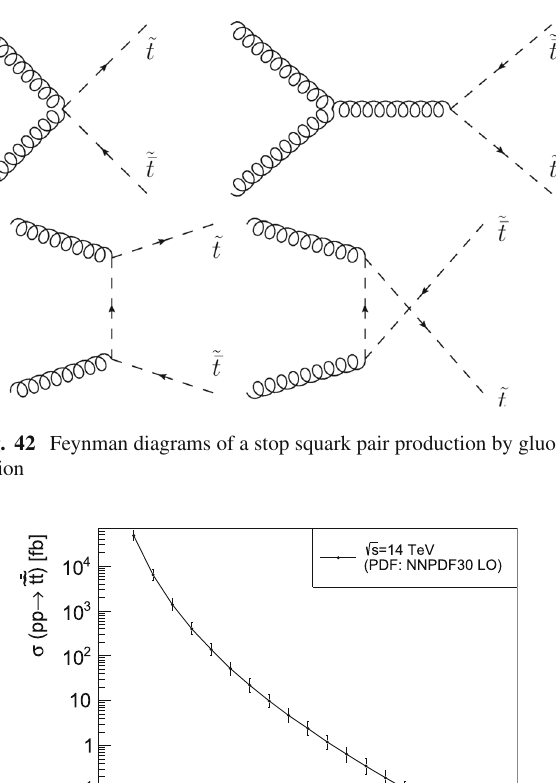
Fig. 43 Leading order cross section σ( pp → ˜ t a function of the stop squark mass m ˜ t . The uncertainties are related to PDF variations and the factorisation and renormalisation